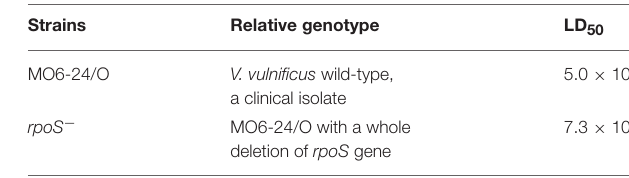
TABLE 3 | Effect of rpoS mutation on the LD 50 of V. vulnificus